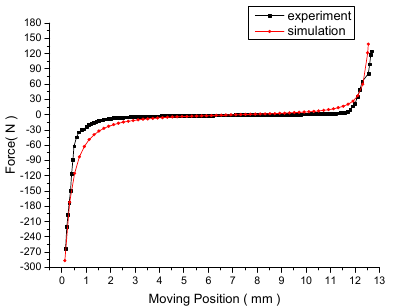
Figure 12. The measurement results and simulation results are shown.